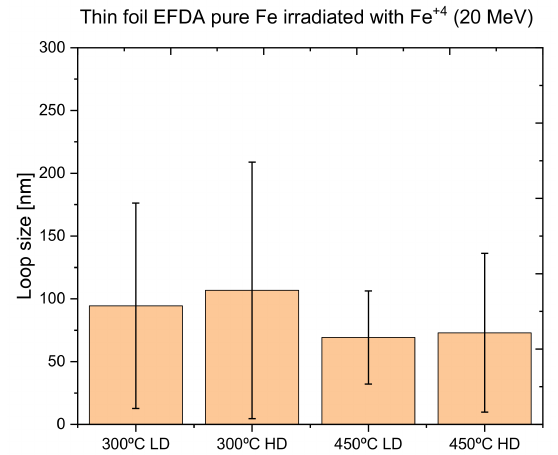
Figure 14. Distribution of dislocation loop sizes under the g vector (112) for an Fe thin foil irradiated with 20 MeV at ( a ) 300 ◦ C, 4.25 × 10 15 ions/cm 2 ; ( b ) 300 ◦ C, 8.5 × 10 15 ions/cm 2 ; ( c ) 450 ◦ C, 4.25 × 10 15 ions/cm 2 ; and ( d ) 450 ◦ C, 8.5 × 10 15 ions/cm 2 .